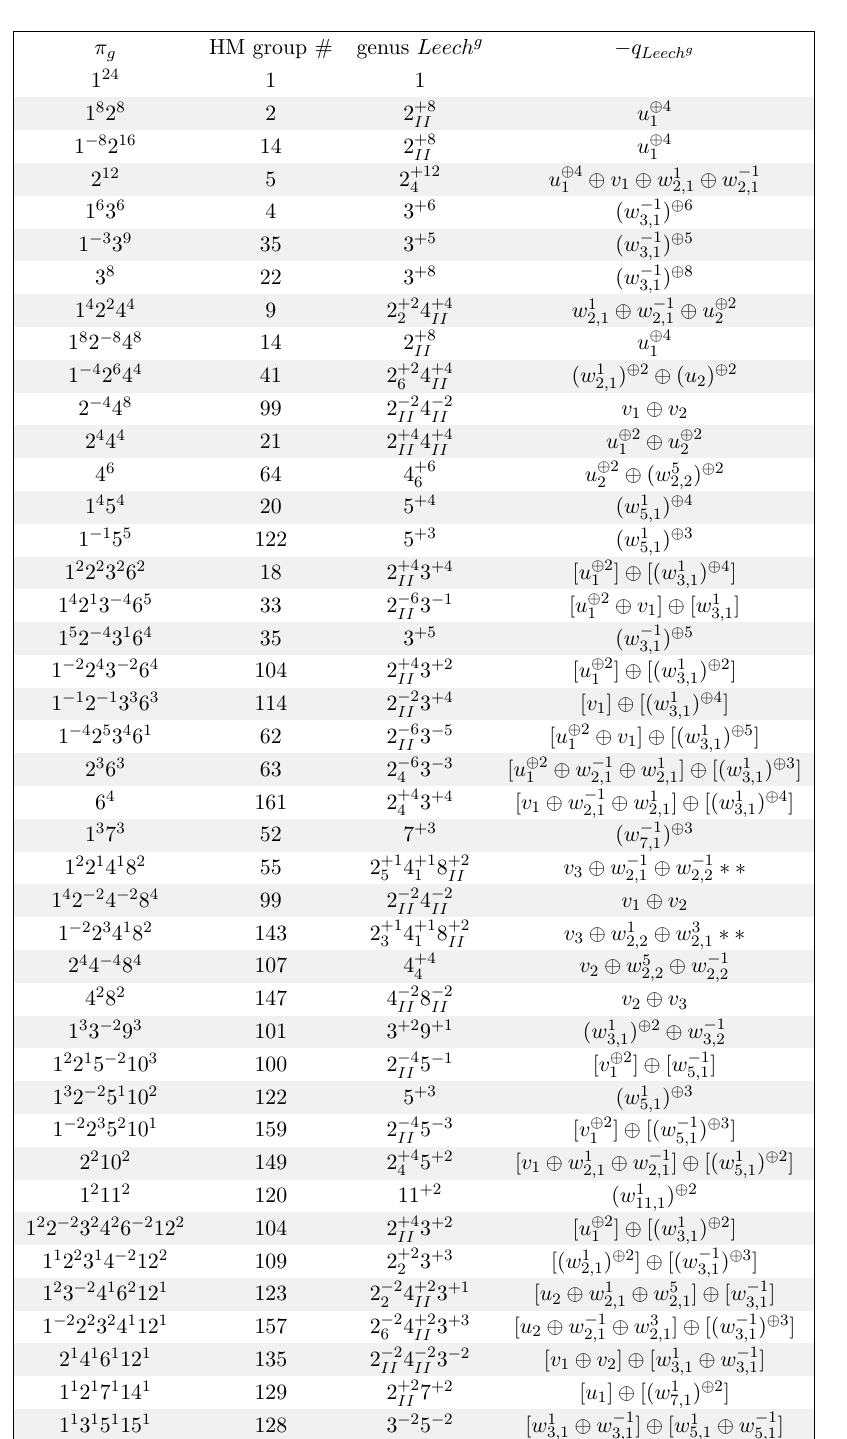
Table 2 . For each Frame shape (cid:25) g , we provide: the number of the smallest group containing g , as listed by H(cid:127)ohn and Mason in [24]; the genus of the (cid:12)xed sublattice Leech g , using the conventions of [24]; and the opposite (cid:0) q Leech g of the discriminant form of Leech g in Miranda and Morrison’s notation [29, 30].